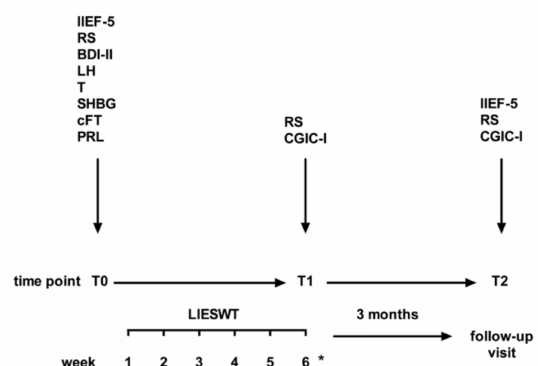
Figure 1. Flow chart of this study. Time points: T0 = first visit prior to commencement of low-intensity extracorporeal shockwaves therapy (LIESWT) sessions (baseline); T1 = last LIESWT session (the sixth for patients who underwent 6 sessions, or the sixth and the twelfth for patients who underwent 12 sessions—see below); T2 = three months after the end of LIESWT sessions. * Four patients, who did not respond or poorly responded to the first LIESWT cycle, underwent another 6 weekly sessions after